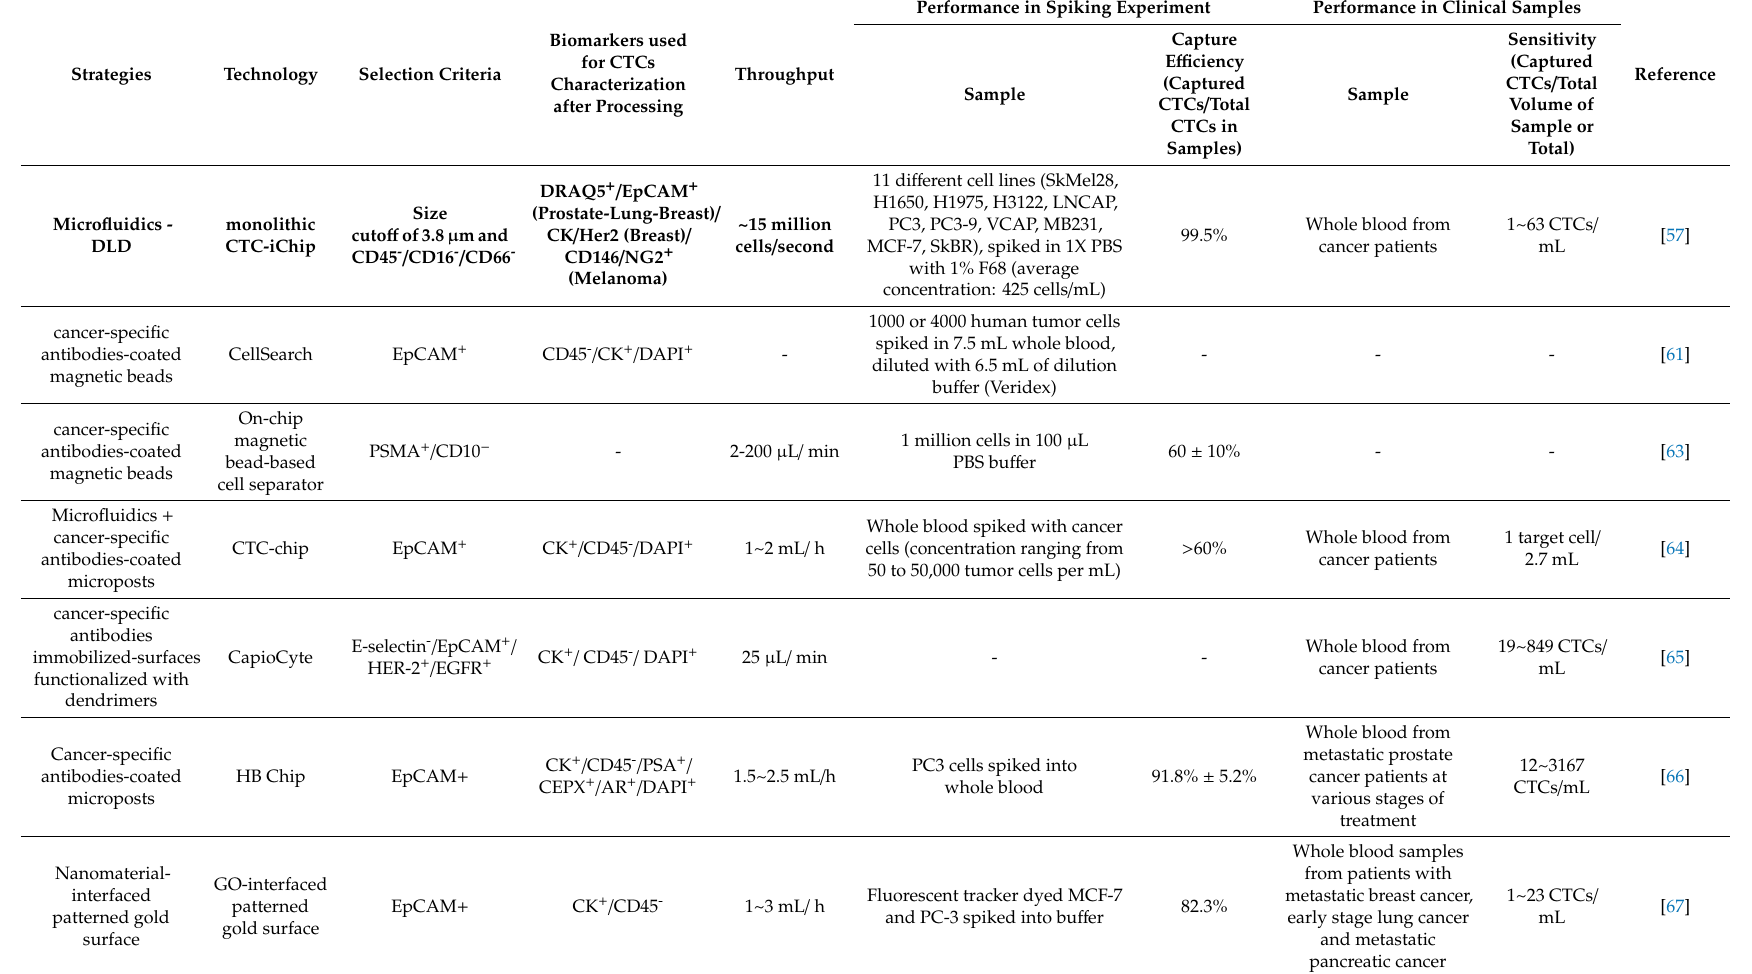
Table 2. Immunoa ffi nity-based technologies for CTCs isolation and